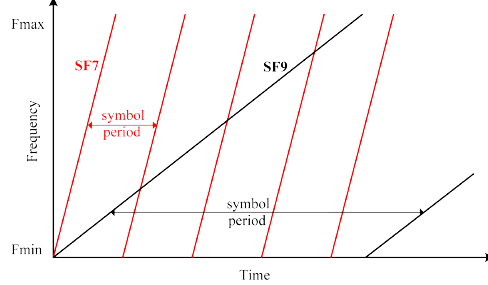
Figure 2. Trade-off between symbol period and spreading